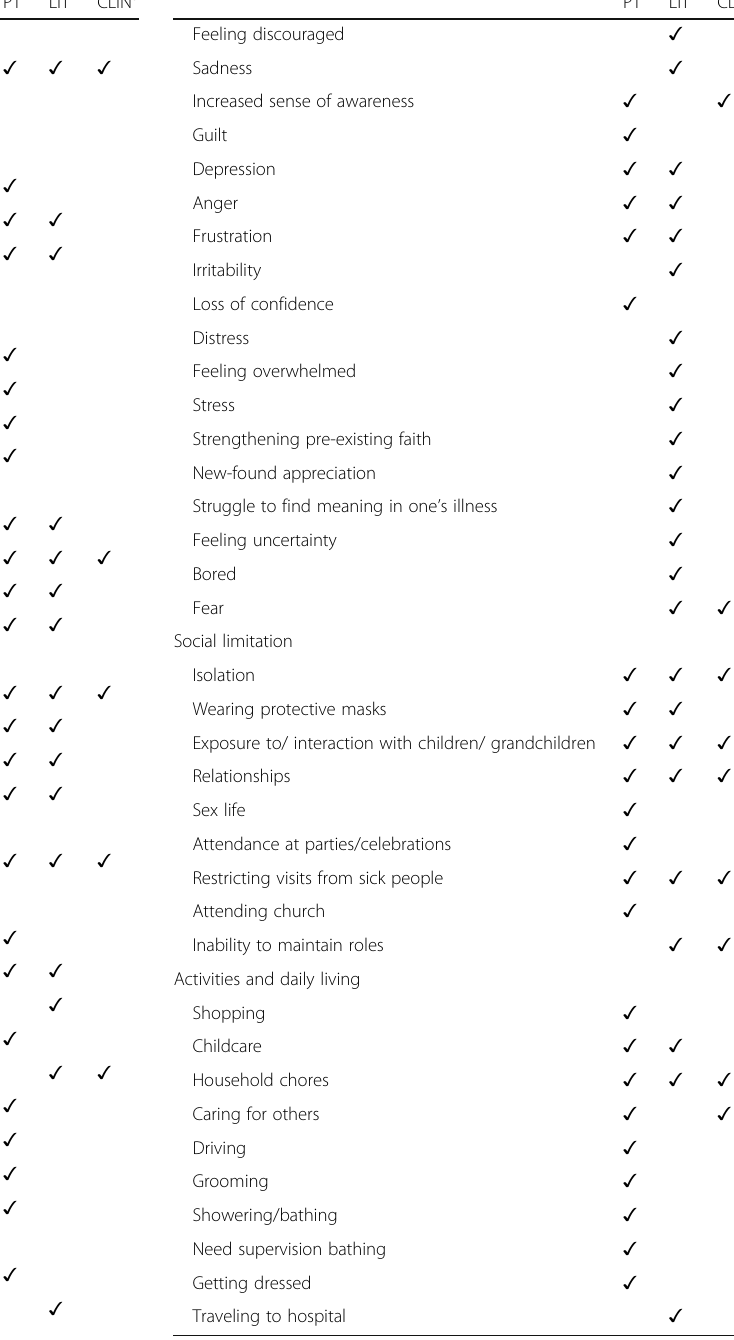
Table 3 Consolidated impact conceptualization of patient experience with MDS, AML and CMML